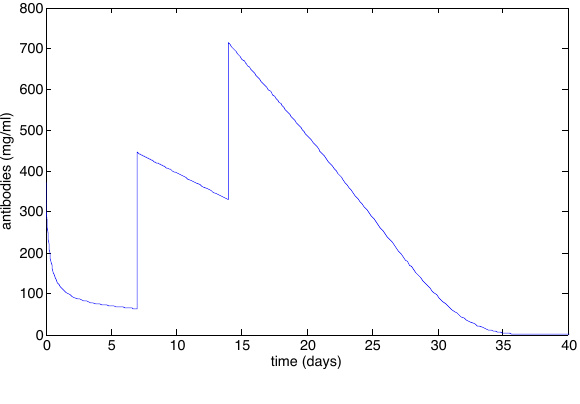
Figure 2. The antibody count for the case when both mutants have 100 -fold resistance